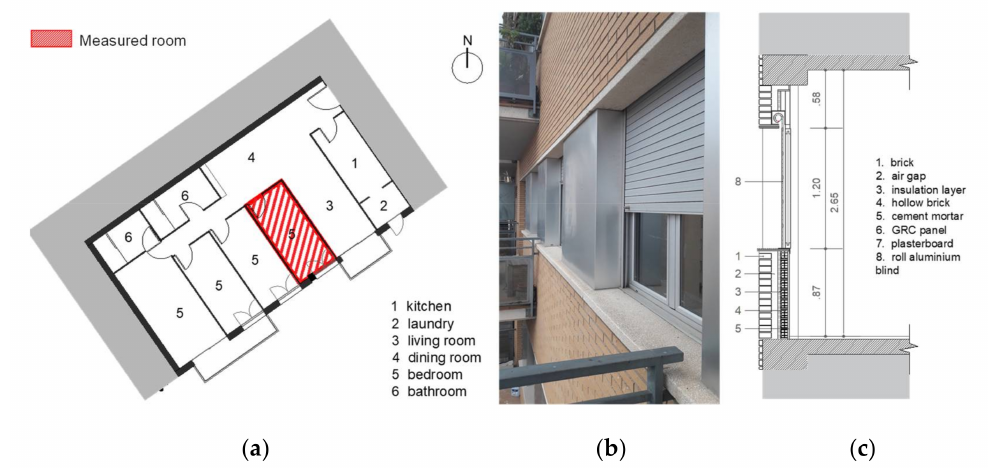
Figure 3. ( a ) Dw1’s plan; ( b ) Dw1’s façade’s picture; ( c ) Dw1’s façade section and its